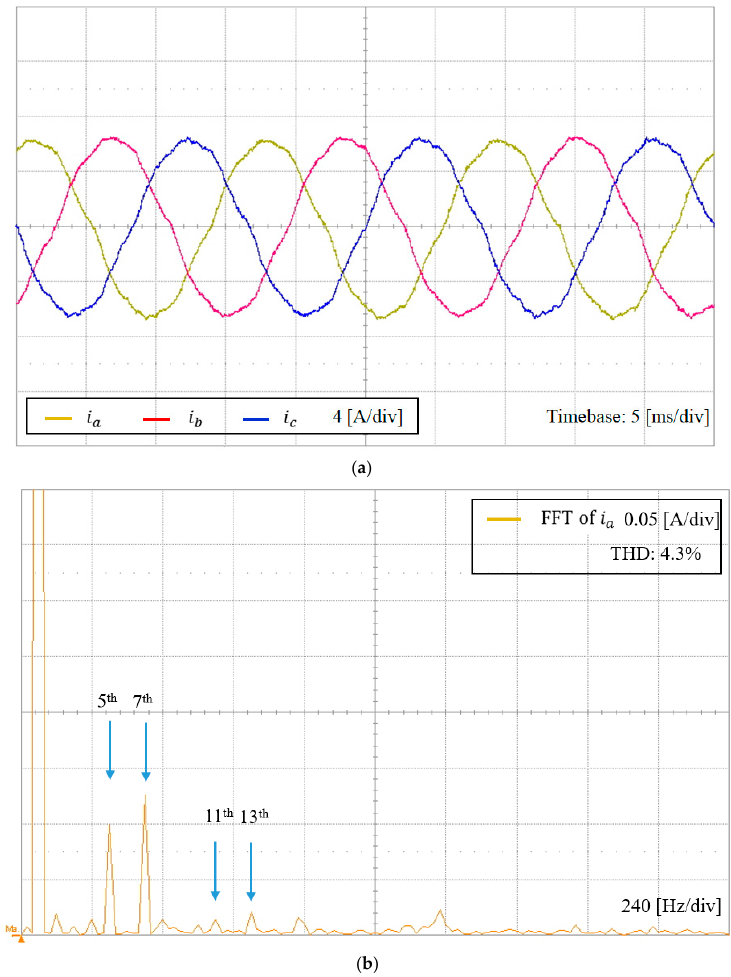
Figure 17. Experimental results of the inverter currents for the PR control scheme under distorted grid condition. ( a ) Phase current waveforms; ( b ) FFT result of a -phase current.